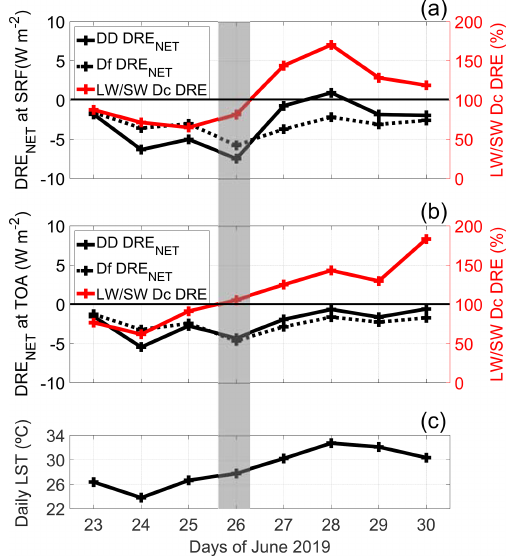
Figure 14. Daily DD DRE NET (solid lines, left axis) and daily Dc LW / SW DRE ratio (dotted lines, right axis) at (a) SRF and (b) TOA; (c) daily mean LST. Site: BCN; time period: 23–30 June. HW1: climatological LST; HW2: air temperature minus 6 ◦ C in the dust layer; HW3: climatological LST and air temperature minus 6 ◦ C in the dust layer. In the LST plot, the climatological surface temperature is also